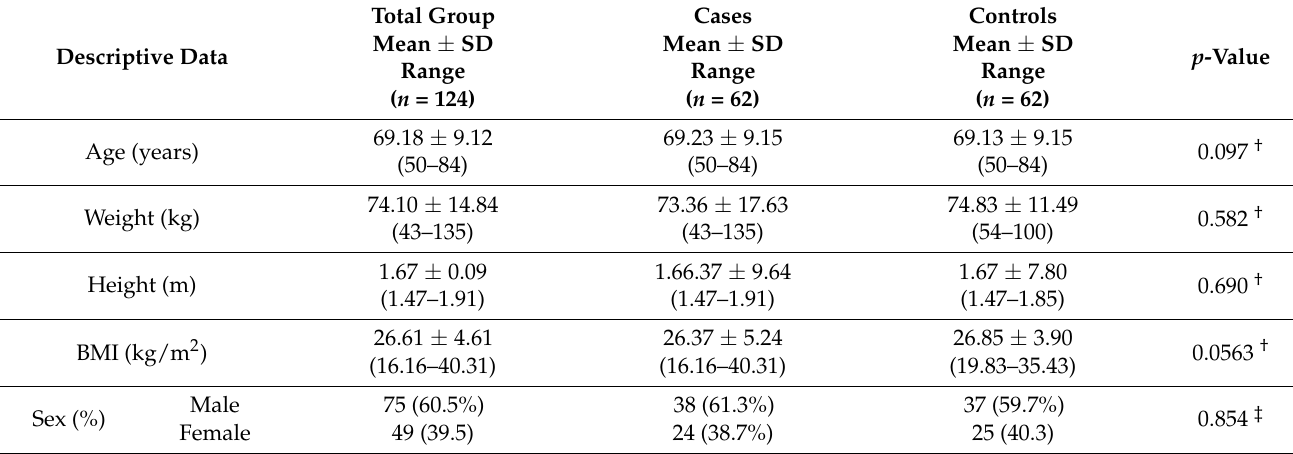
Table 1. Descriptive data of the Parkinson’s patients and healthy matched-paired controls.